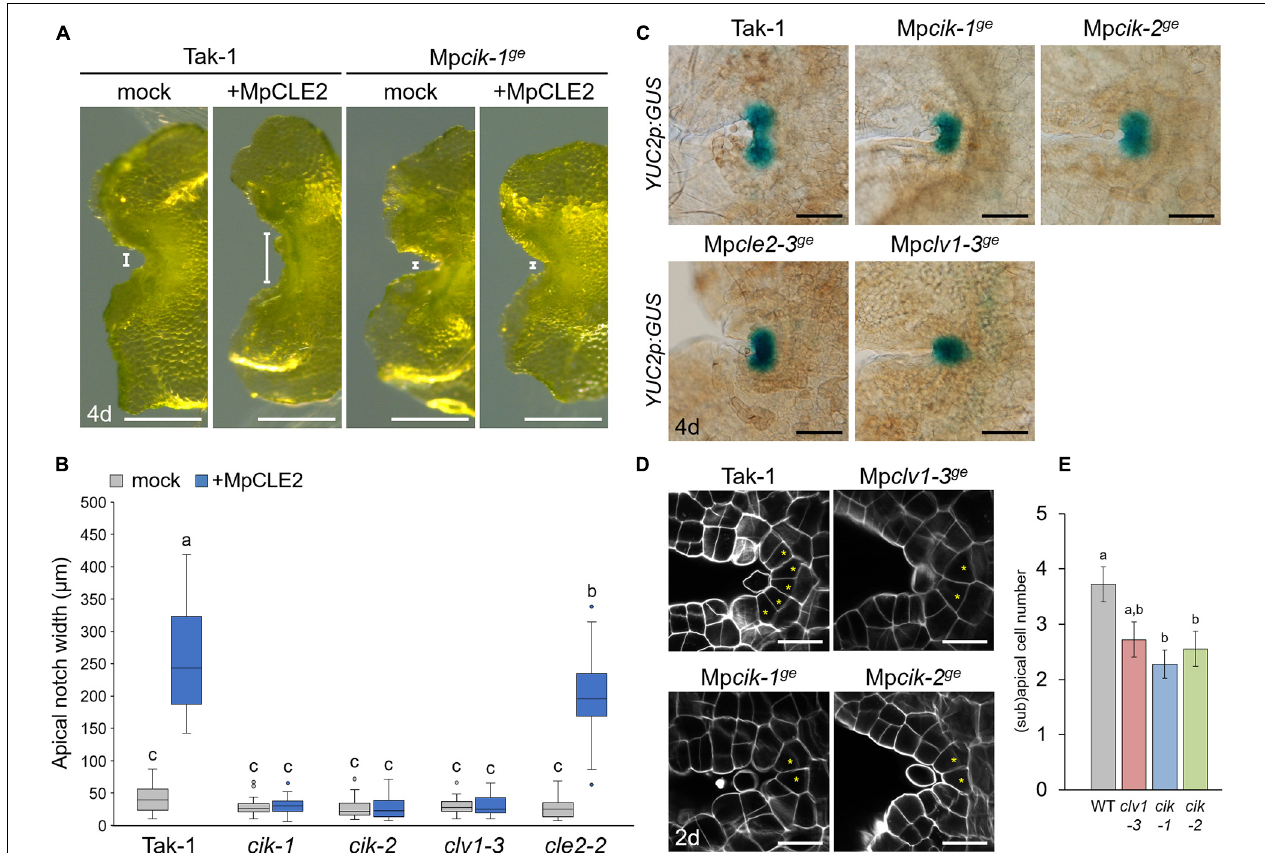
FIGURE 2 | Phenotypes of Mp CIK knockout alleles in the apical notch. (A) Morphology of 4-day-old gemmalings grown with or without MpCLE2 peptide as indicated above. Width of apical notch is indicated by white lines. (B) Quantification of apical notch width. Data sharing superscripts are not significantly different from each other in Tukey’s HSD test, p < 0.05; n = 30. (C) pro Mp YUC2:GUS marker in 4-day-old gemmalings. Genetic background is indicated above each panel. (D) Confocal imaging of stem cell zone in 2-day-old gemmalings. Asterisks indicate apical and subapical cells. (E) Quantification of the number of apical/subapical cells. Mean and SEM: n = 18. Scale bars represent 500 µ m in panel (A) , 100 µ m in panel (C) and 20 µ m in panel (D)